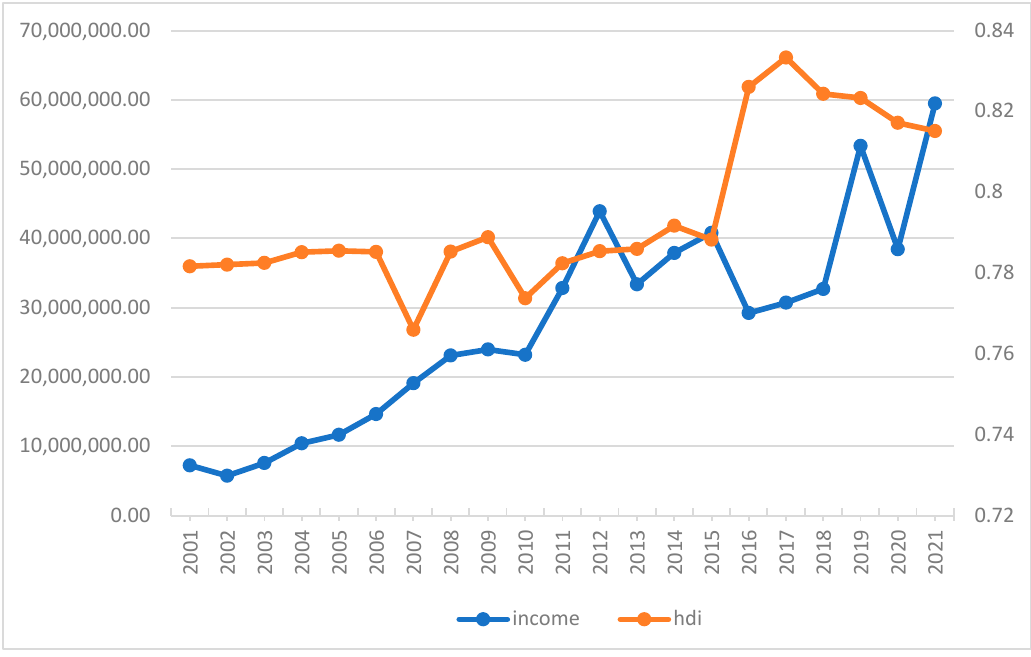
Figure 5. RHDI and FRA Istanbul 2001–2021. Source: Turk Statistical Institute.